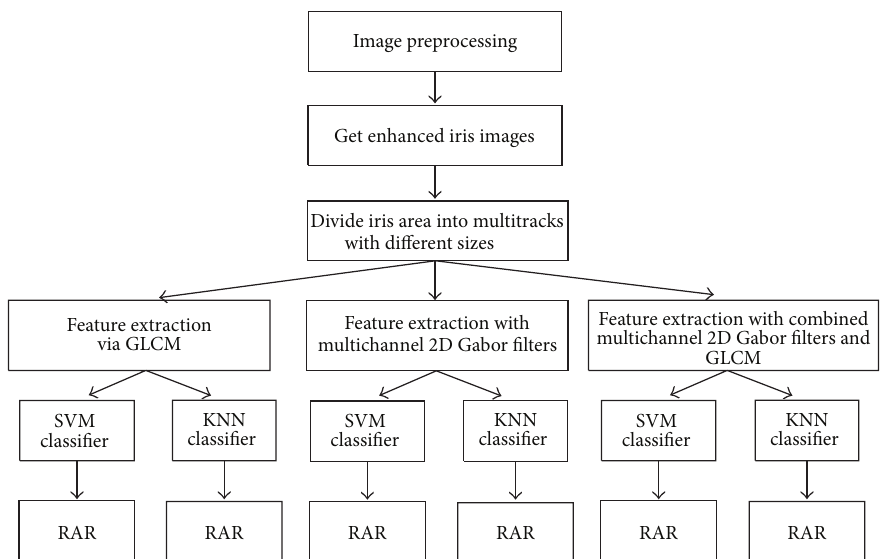
Figure 3: Analysis processing